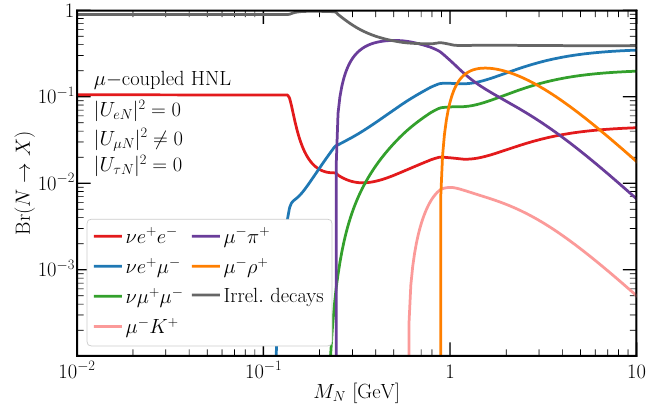
Figure 22 . The branching ratio of a muon-coupled HNL N into di(cid:11)erent (cid:12)nal states as a function of its mass M N . The grey curve is a collection of decays considered to be irrelevant, as described in the